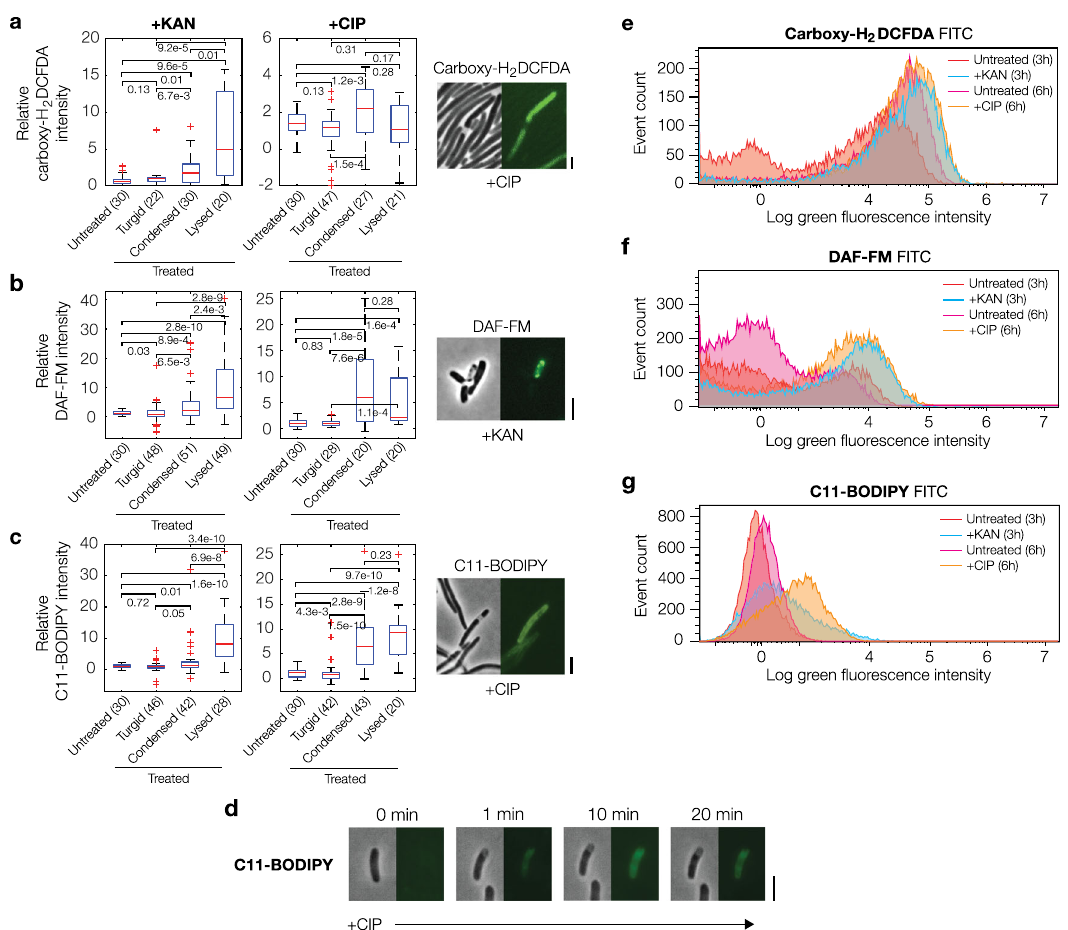
Fig. 4 Cytoplasmic condensation is associated with the accumulation of reactive metabolic by-products. a Fluorescence intensities of antibiotic-treated E. coli in the presence of the ROS-sensitive dye carboxy-H fl oxacin-treated cells imaged in phase contrast and 2 DCFDA. A representative view of cipro epi fl uorescence is shown. Here and below, the kanamycin and cipro fl oxacin concentrations used were 10× MIC, error bars represent one standard deviation, and scale bars indicate 3 μ m. The number of cells in each group are indicated in parentheses. Box plots indicating the median (center), 25th and 75th percentile (bounds of box), and extreme data points not considered outliers (bounds of whiskers) are shown, and red crosses indicate outliers including the minimum and maximum values. p -values for two-sample Kolmogorov-Smirnov tests are shown next to corresponding brackets. b , c Same as ( a ), but for DAF-FM, a dye sensitive to nitric oxide ( b ), and C11-BODIPY, a lipid peroxidation-sensitive dye ( c ). d A representative timelapse of a cipro fl oxacin-treated E. coli cell in the presence of C11-BODIPY. Times show duration after the fi rst image, and results are representative of three